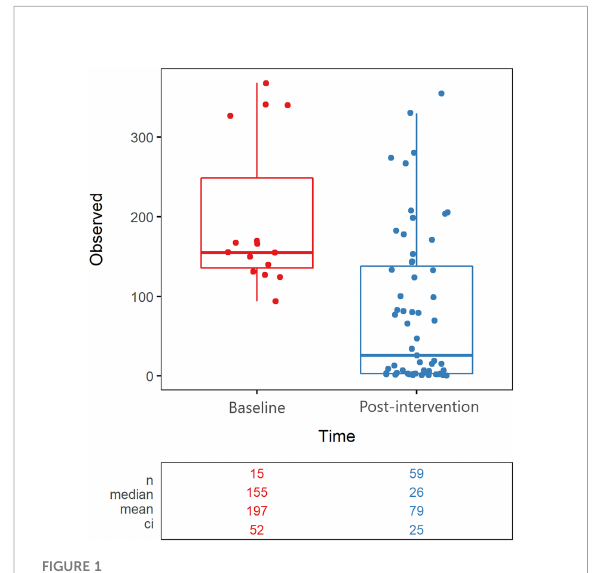
FIGURE 1 Alpha Diversity boxplot compares observed taxonomic richness between surface swabs collected prior to (red) and after (blue) the intervention of AIONX ® cleanSURFACES ® . A signi fi cant decrease in observed species richness is observed after the intervention of the AIONX ® cleanSURFACES ® (p=0.000179). The number of unique taxa observed in each sample is reported, along with summary statistics for each